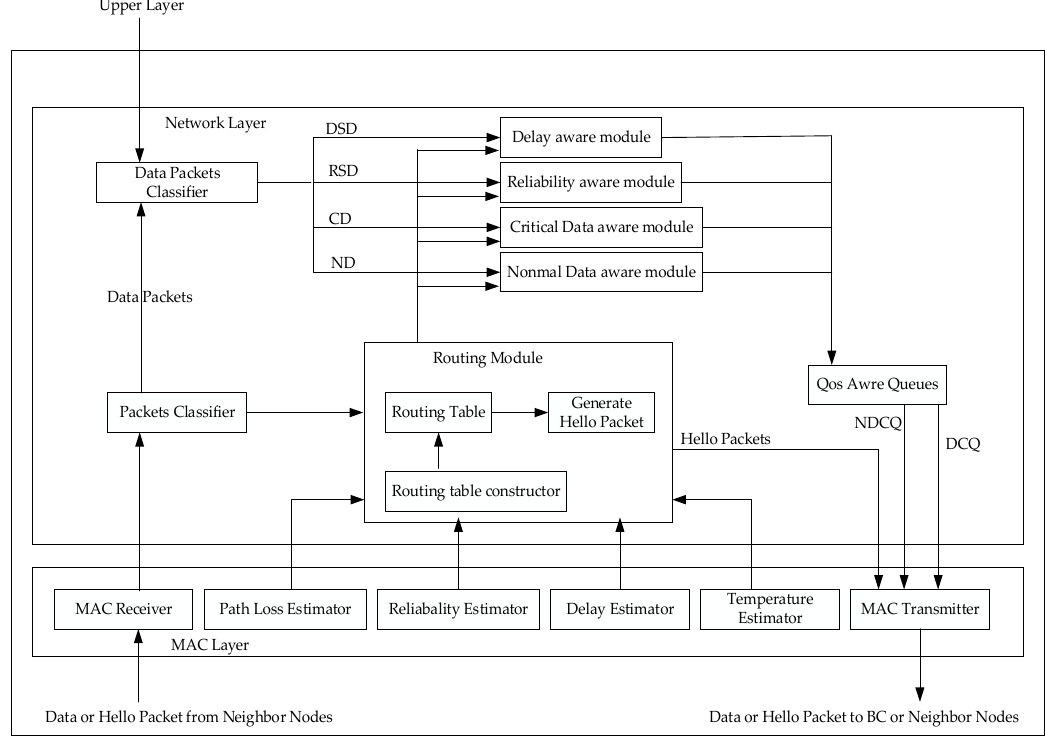
Figure 13. Modular diagram of the HDPR protocol. Table 6. Comparison of the Qos-based routing protocols.